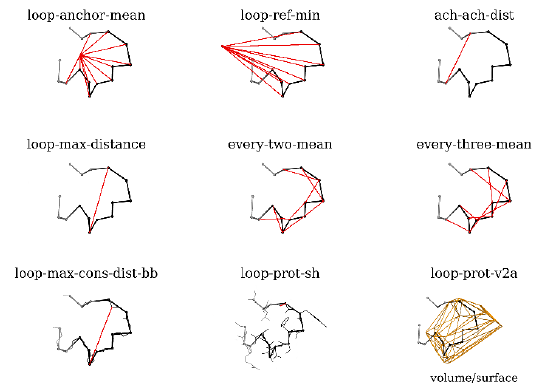
Figure 1. The set of nine geometry-based loop parameters (see Methods section for details). The analyzed loop is shown as black lines, with C α atoms marked as small balls. The red lines show the distances used for calculations; the orange shape represents the ConvexHull approximation of the volume of loop